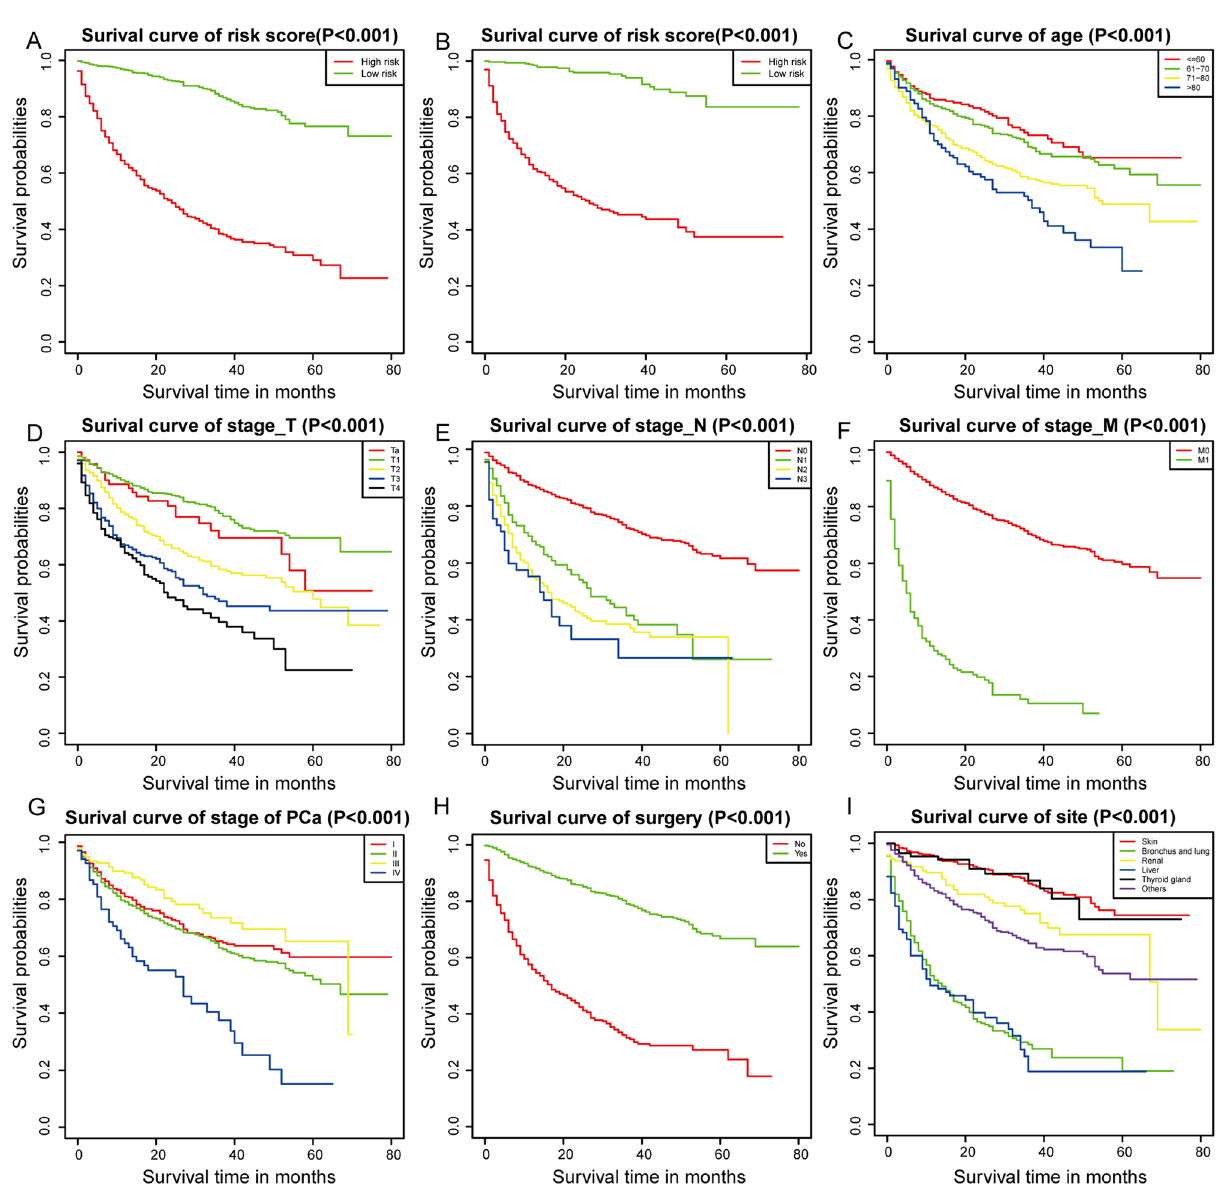
Figure 3. Kaplan–Meier analysis for overall survival (OS) of second primary malignancy (SPM) after prostate cancer (PCa) based on risk score in the training set ( p < 0.001) ( A ) and the validation set ( p < 0.001) ( B ), age ( p < 0.001) ( C ), stage T ( p < 0.001) ( D ), stage N ( p < 0.001) ( E ), stage M ( p < 0.001) ( F ), PCa stage ( p < 0.001) ( G ), SPM surgery history ( p < 0.001) ( H ), and site of SPMs ( p < 0.001) ( I